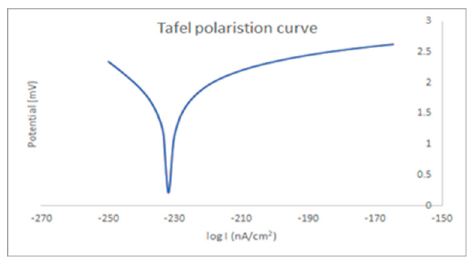
Figure 2. Tafel polarization curve of the